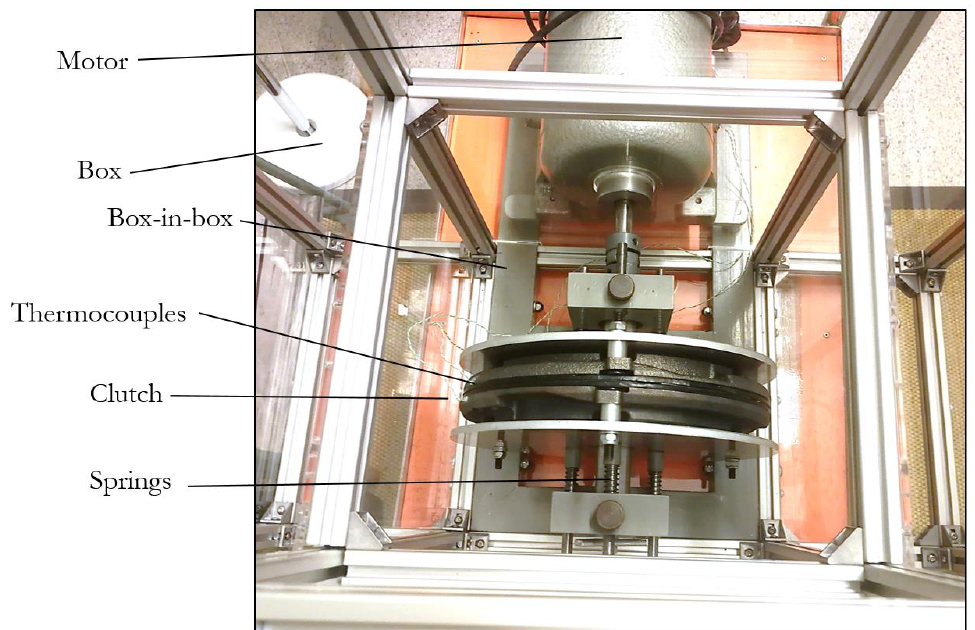
Figure 4. Top view photo of the clutch